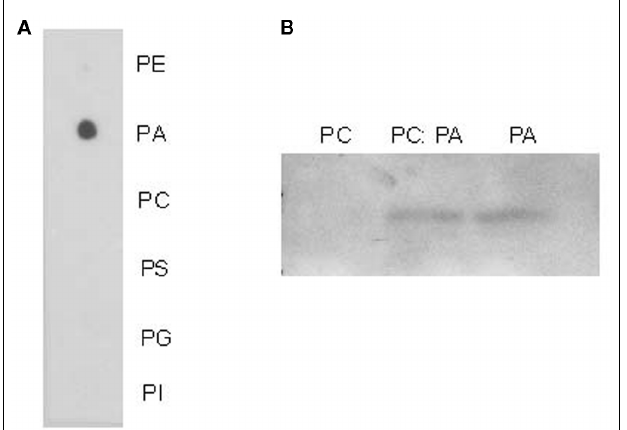
FIGURE 1 | Lipid-binding assays. (A) Protein–lipid overlay assay using purified PLAFP.Ten nanomole of selected phospholipids were spotted on a hybond-C membrane and overlaid it with 1 μ l/ml purified PLAFP. PE, phosphatidyl ethanolamine; PA, phosphatidic acid; PC, phosphatidyl choline; PS, phosphatidyl serine; PG, phosphatidyl glycerol; PI, phosphatidyl inositol. (B) Liposome binding assay using purified PLAFP. Liposomes